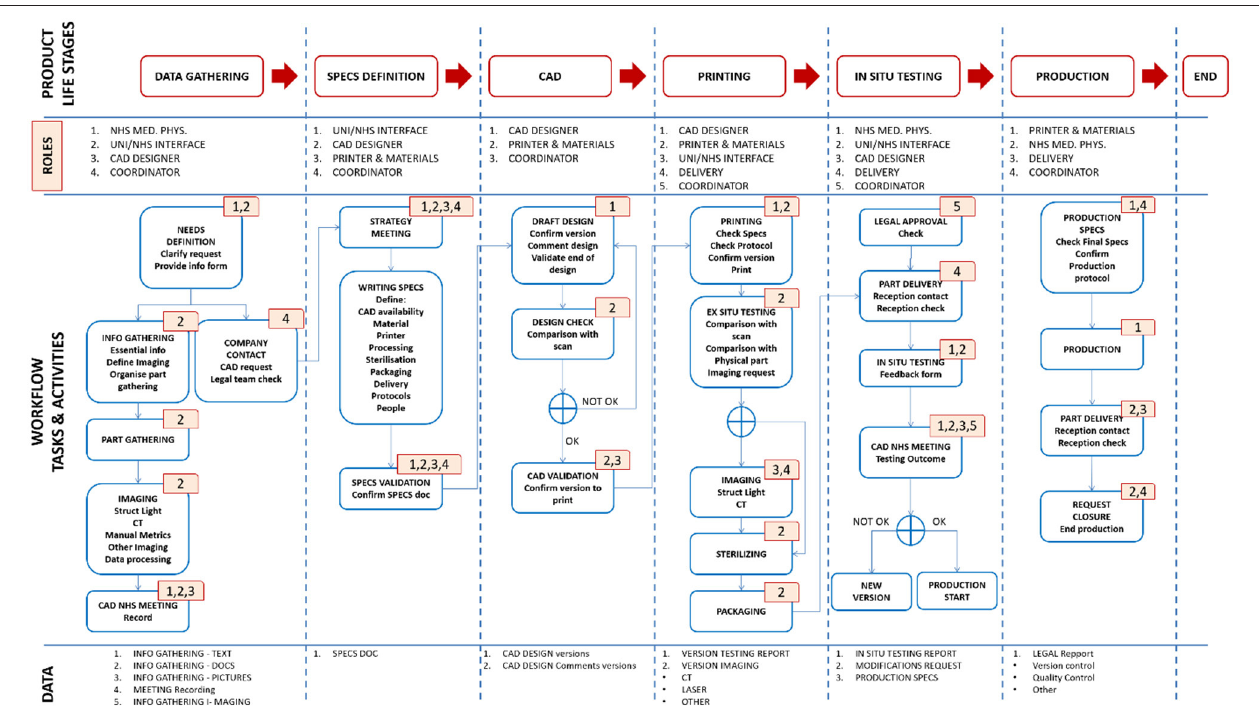
FIGURE 12 | Schematic diagram of the Aras PLM tool for the production of bespoke medical equipment. The first row highlights the product life stages. The second row identifies the personnel roles at each stage. The third row shows the workflow of tasks and activities. The roles associated with each task or activity are identified by the corresponding numbers (top right corner of each task box) e.g., the first task in the “data gathering” stage has numbers 1 and 2, meaning it involves NHS Medical Physics personnel, and personnel working at the interface between the NHS and the engineering organisation. The fourth row outlines the data